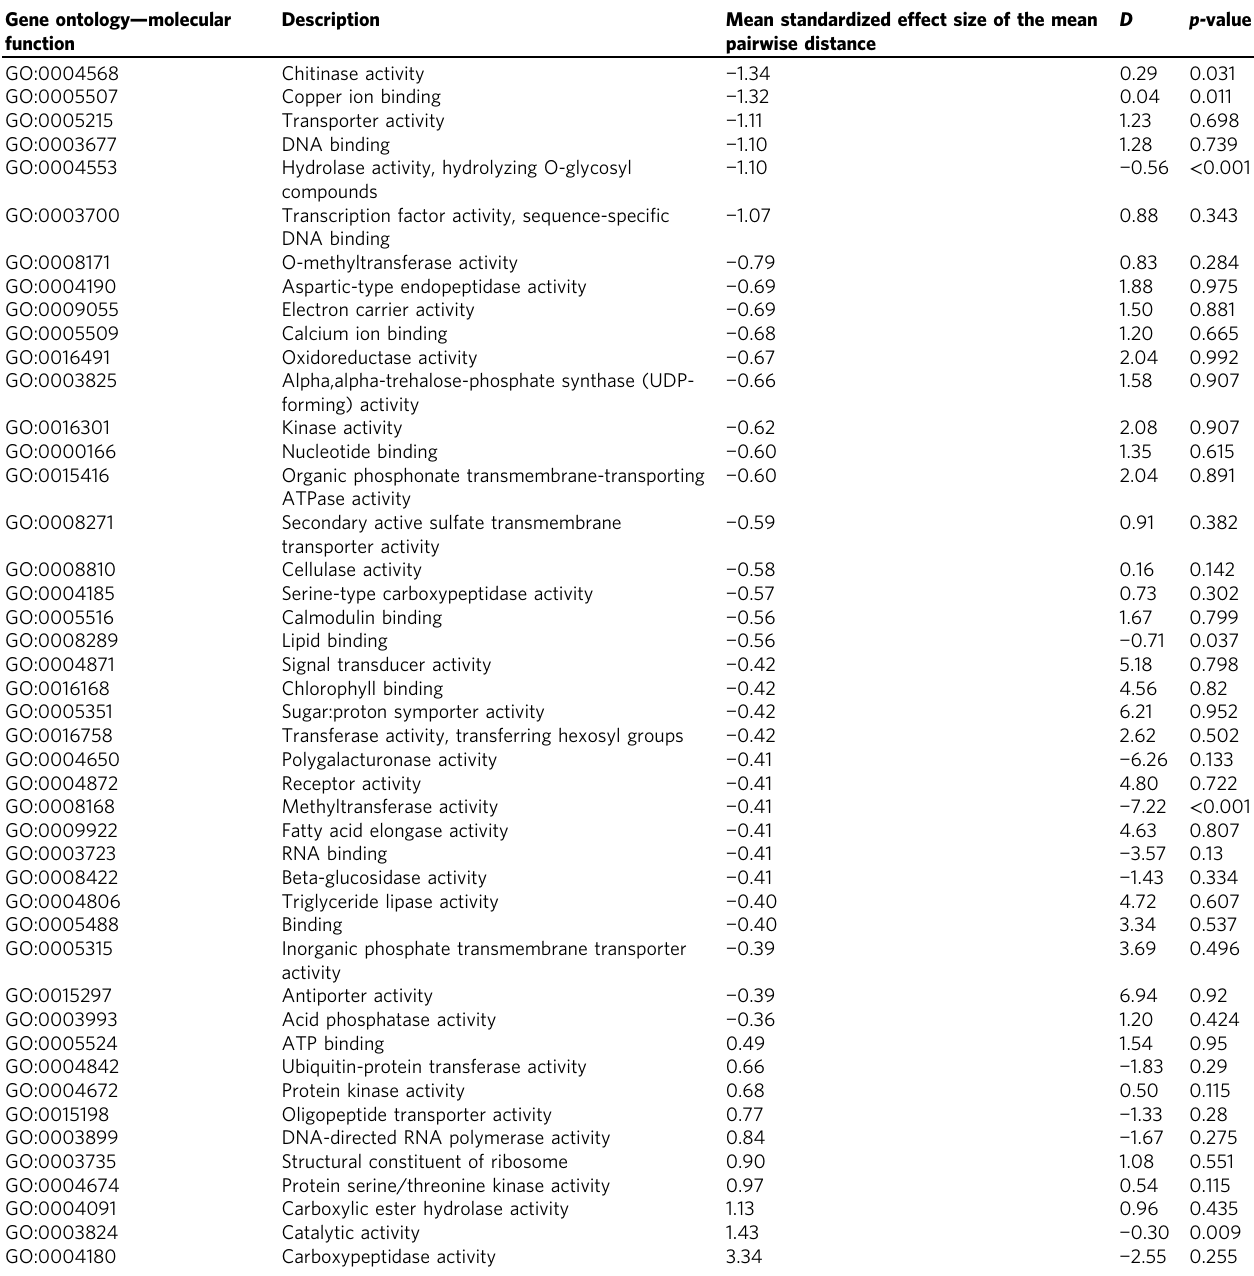
The fi rst two columns provide the gene ontology identi fi er and description. The third column provides the average of the standardized effect size of the mean pairwise distancevalues for 630 20×20m subplots.Negativestandardizedeffectsizevaluesindicatespecieswithmoresimilarthanexpectedgenesetenrichmentinresponsetodroughtarenaturallyco-occurring.Thefourthcolumnpresentsthe D statistic where a value of 1 indicates phylogenetic signal in the expression data (i.e., consistent with Brownian motion evolution on the phylogeny) and values higher than 1 indicate increasingly labile evolution. The fi nal column presents the p -value for the D